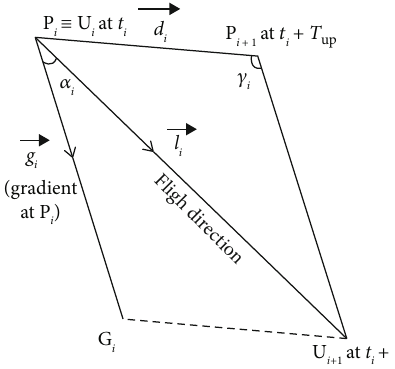
Figure 4: Self-navigation in early time of searching an object on the move — the UAV adjusts its fl ying direction on “ wait-in-front ” tactic, heading toward U instead of G i +1 i